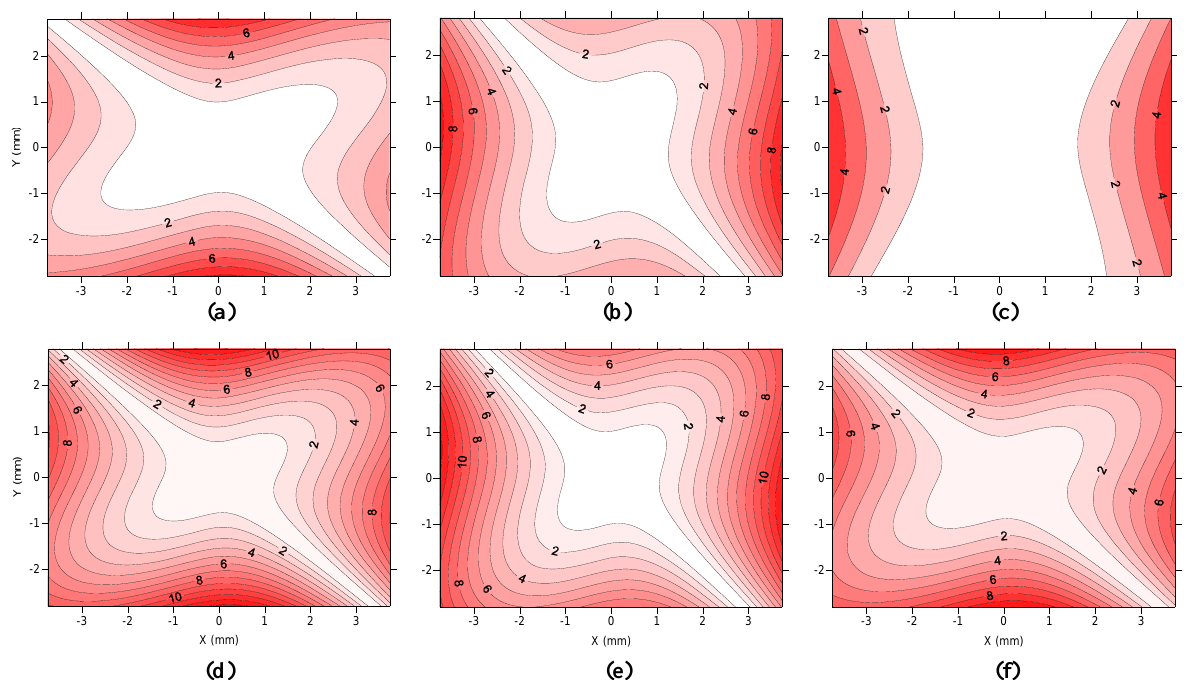
Figure 9. Radial component of the decentering distortion (in microns) in cameras A (a), B (b), C (c), D (d), E (e) and F (f).